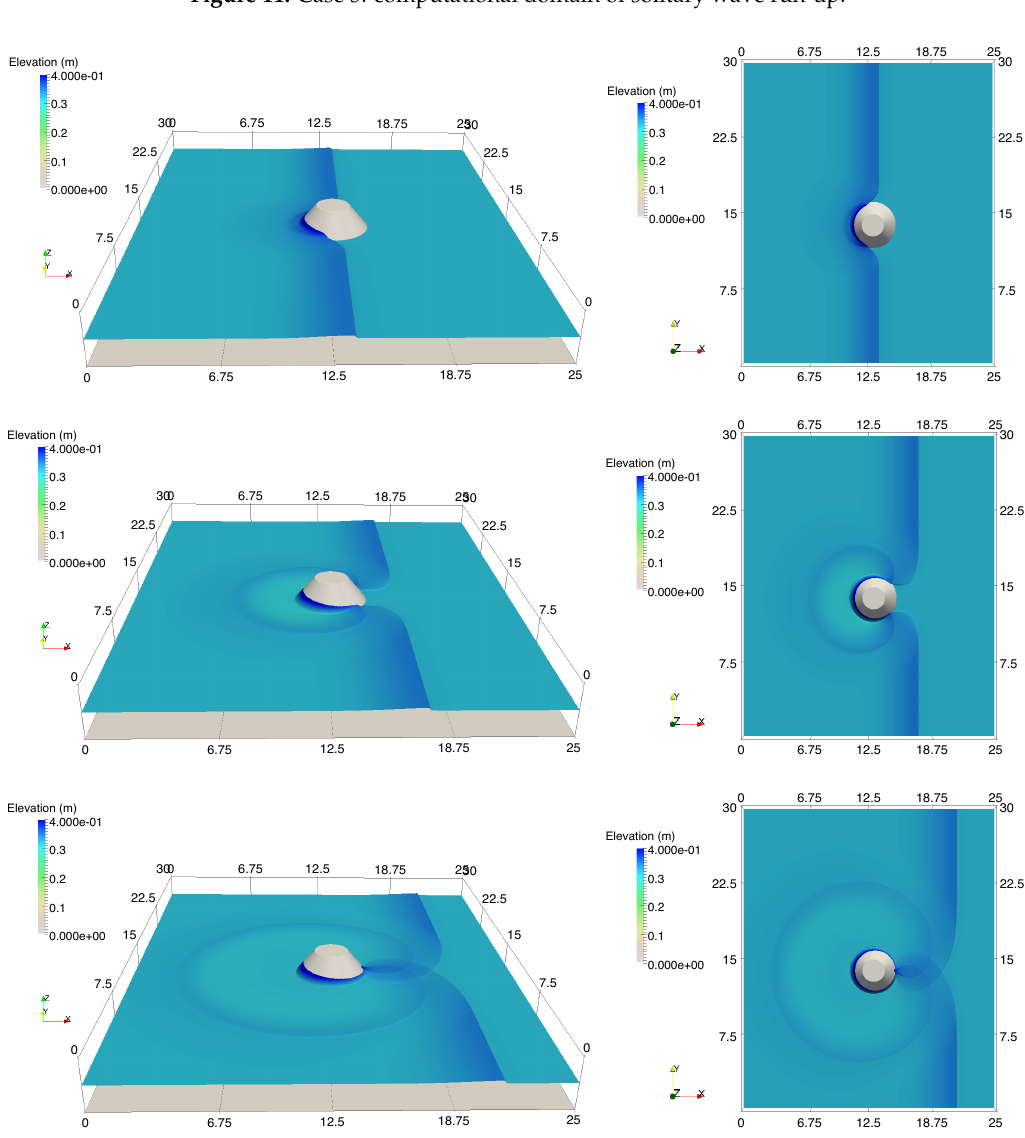
Figure 12. Case 3: numerical results using the CU scheme at 9, 11, and 13